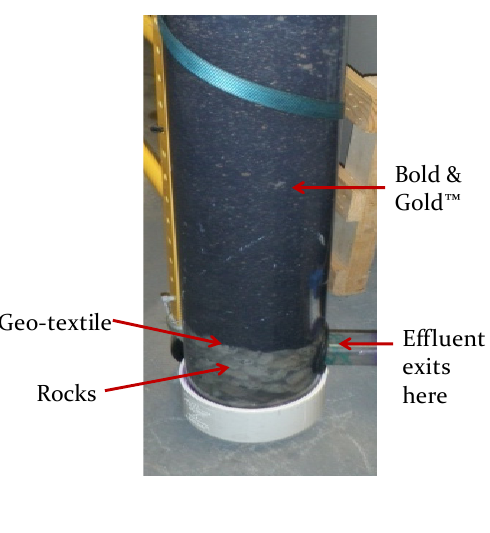
Figure 7. Column test apparatus.